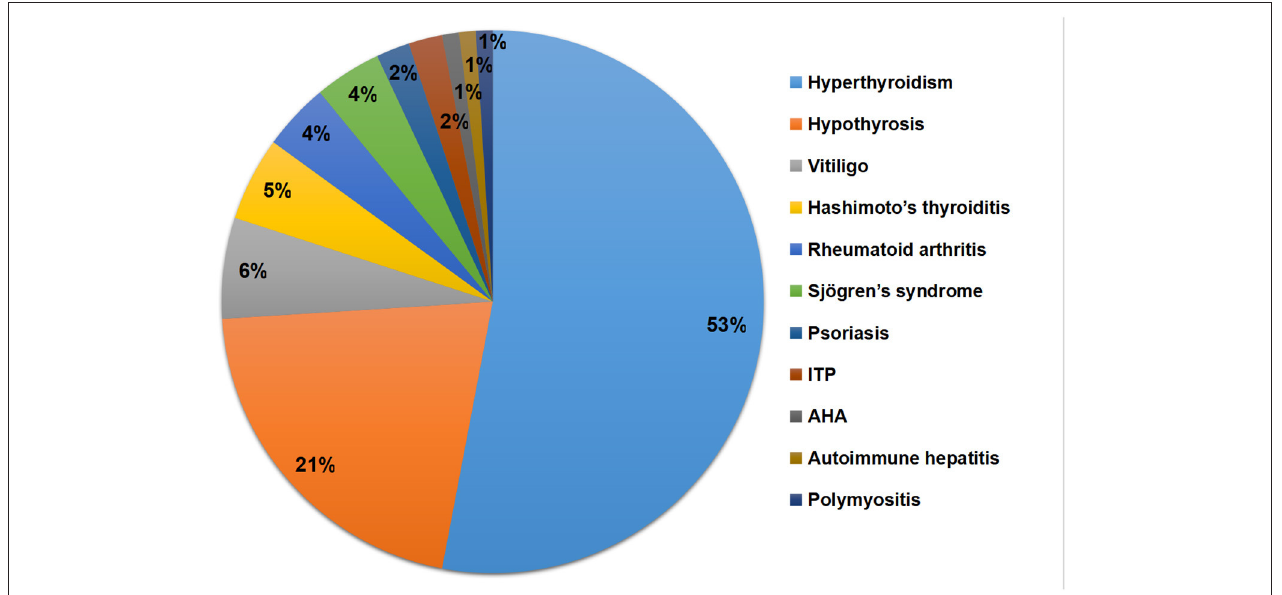
FIGURE 3 | Types and percentages of concomitant ADs. ADs, Autoimmune diseases; ITP, Immune thrombocytopenic purpura; AHA, Autoimmune hemolytic anemia.